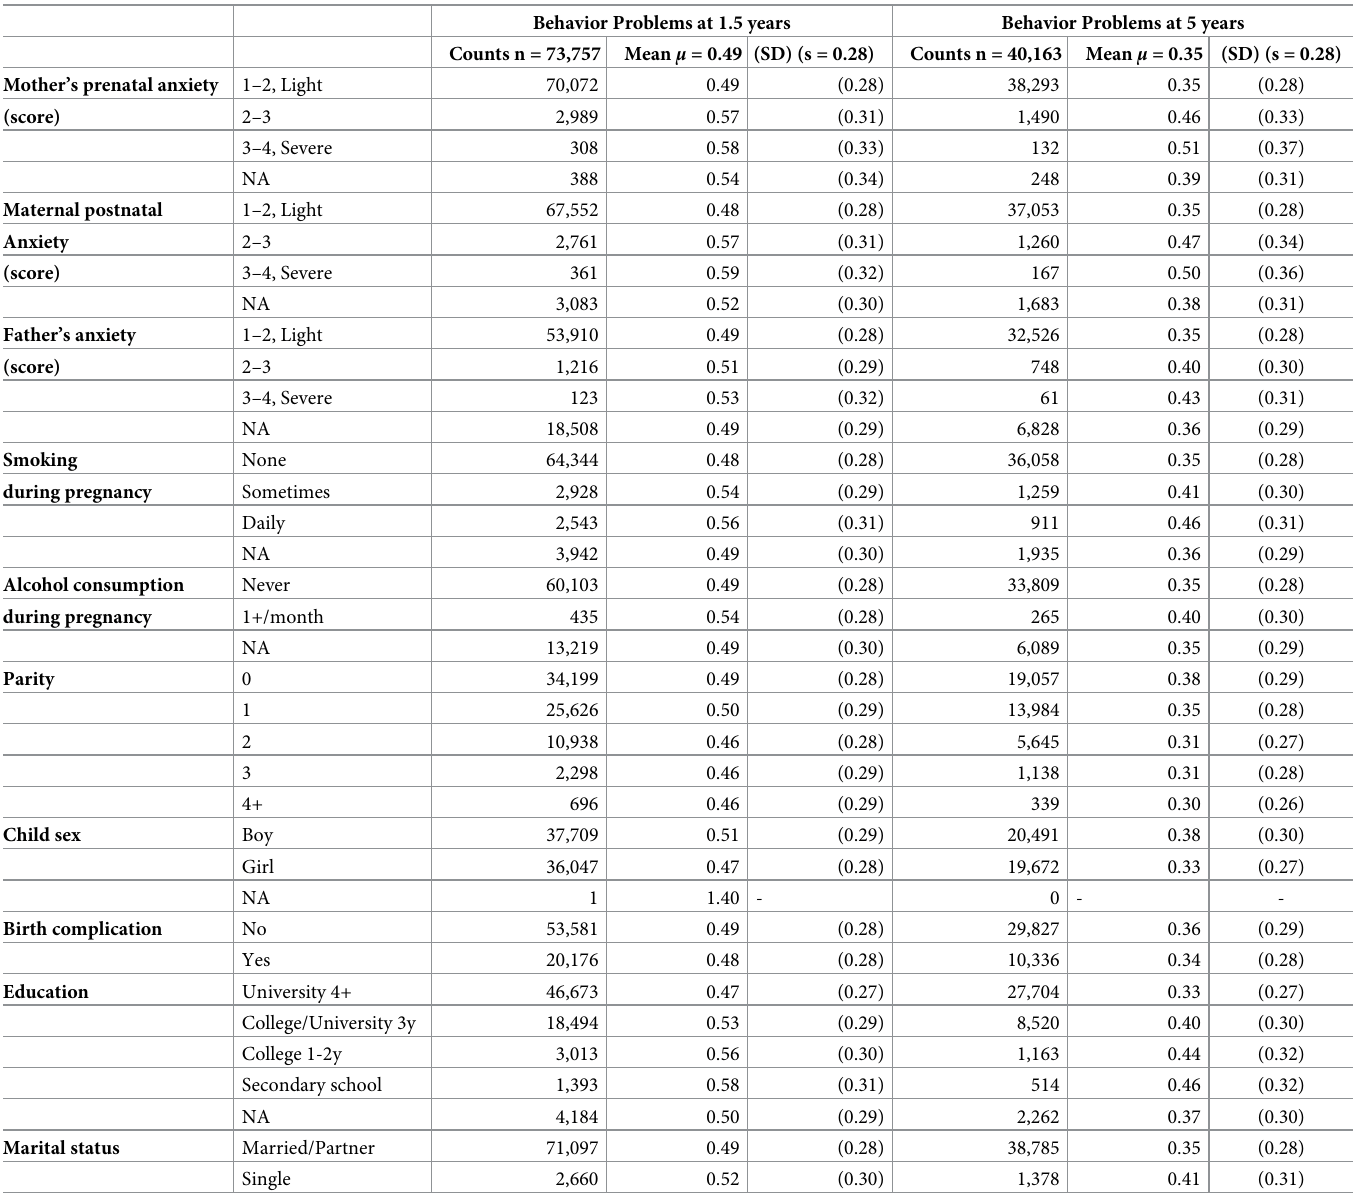
Table 1. Characteristics of full